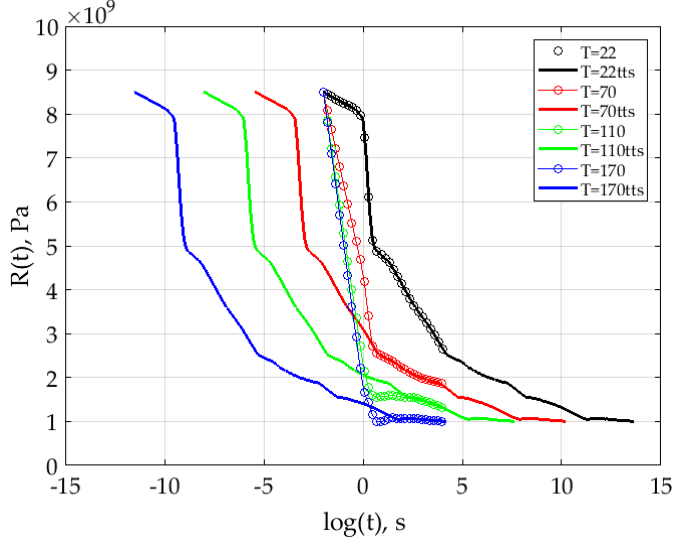
Figure 4. Convergence of the generalized relaxation curve and calculated relaxation curves. Bold lines (tts) — calculated relaxation function curves; lines with markers — original relaxation function curves. Black curves for temperature 22°C, red curves for temperature 70°C, green curves for temperature 110°C, blue curves for temperature 170°C.